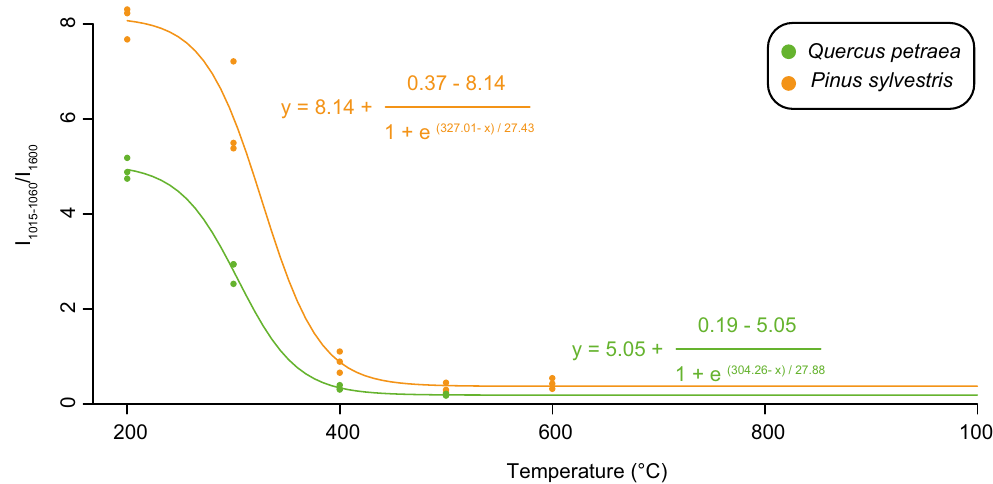
Figure 2. Relationships between the I 1015–1060 /I 1600 and carbonisation temperatures in oak and pine charred